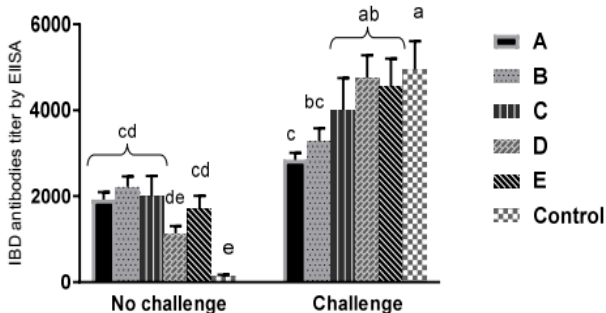
Figure 3. IBDV antibody titers with standard deviation in commercial broilers at 35 days of age in challenged (seven days post challenge) and non-challenged subgroups. (A): Vaccinated with HVT-IBD vector vaccine at hatchery. (B): Vaccinated with immune complex at hatchery. (C): Received intermediate plus (228E) at 14 days of age by eye drop. (D): Received two doses of intermediate (D78) at 12 and 22 days of age by eye drop. (E): Like group D but inoculated also with IBD killed vaccine s/c at five days of age. (Control): Did not receive any IBD vaccines either challenged at 28 days of age with vvIBDV or with saline (non-challenged) by oculo-nasal route. Different superscript letters indicate significant differences between groups ( p < 0.05). IBD immune status was considered negative if ELISA titer was less than 875 according to commercial indirect classical ELISA kits (ID. Vet, France) manufacturer’s instructions.